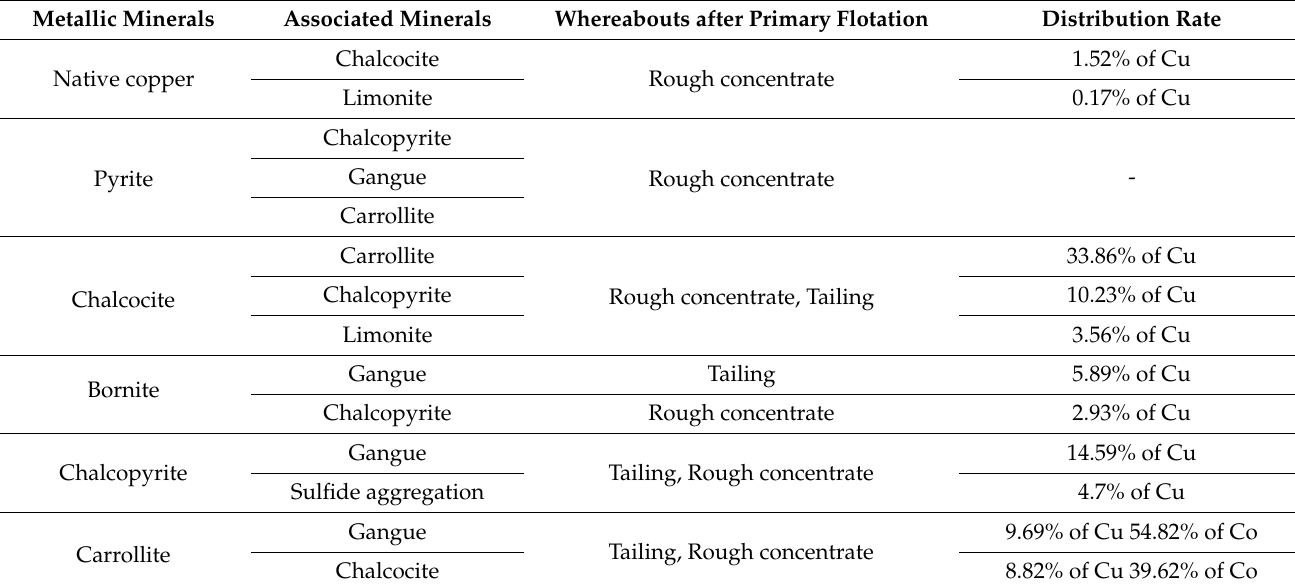
Table 5. The associated minerals of major sulfide minerals.